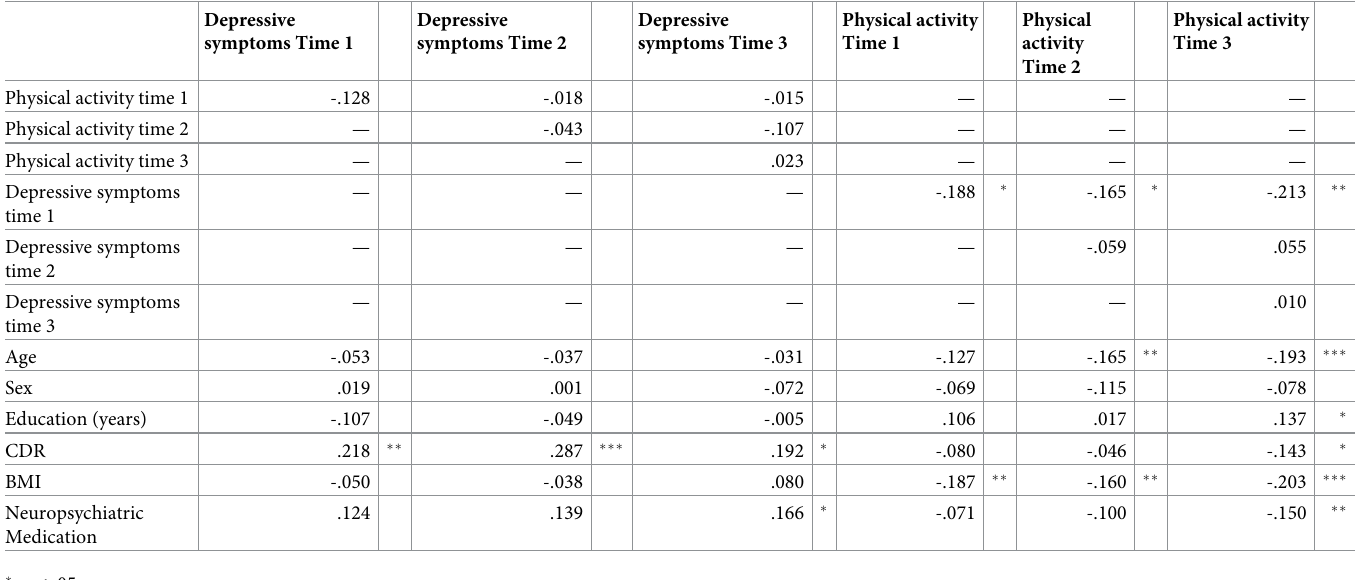
Table 2. Results of structural equation models of physical activity as a predictor of depressive symptoms on the GDS and depressive symptoms on the GDS as a pre- dictor of physical activity across three waves (standardized estimates).